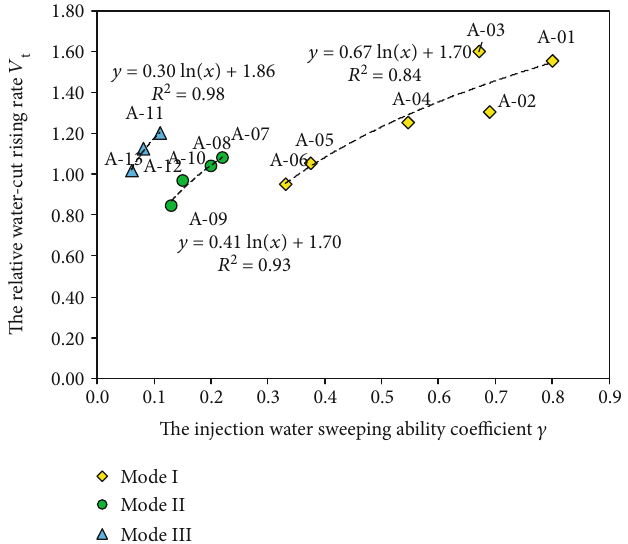
Figure 6: The correlation of the injection water seepage ability coe ffi cient γ and the relative water-cut increasing rate V